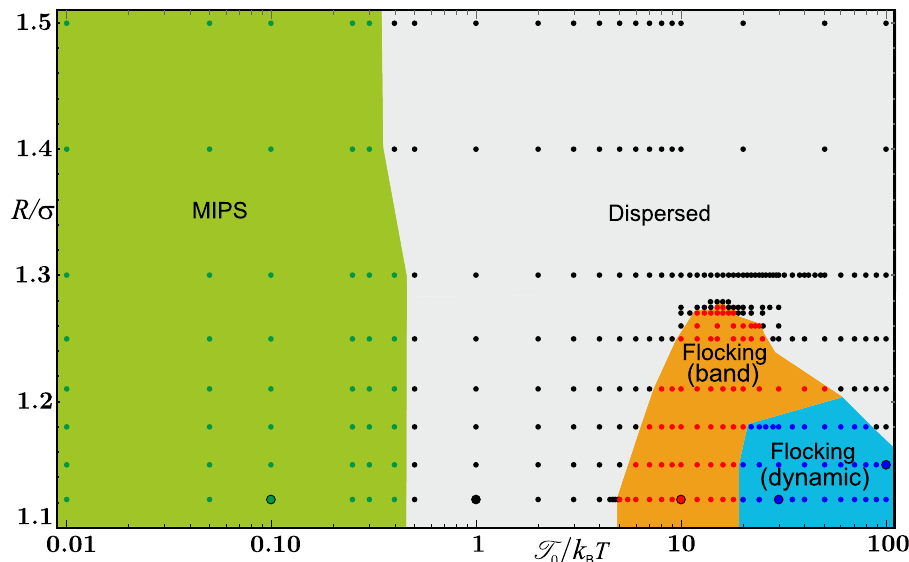
Figure 2. State diagram of the system as a function of the non-reciprocal interaction range R and interaction amplitude T 0 . The T 0 axis is presented in the logarithmic scale and includes data over the range of five orders of magnitude. Apart from the dispersed state, three ordered states are observed, which we term MIPS, flocking (band) and flocking (dynamic). State boundaries have been sketched by using simulation data, represented by 0.24 and Pe 80 . The states of the snapshots circles of different colors. The system is characterized by (cid:31) = = presented in Fig. 3 are indicated by enlarged